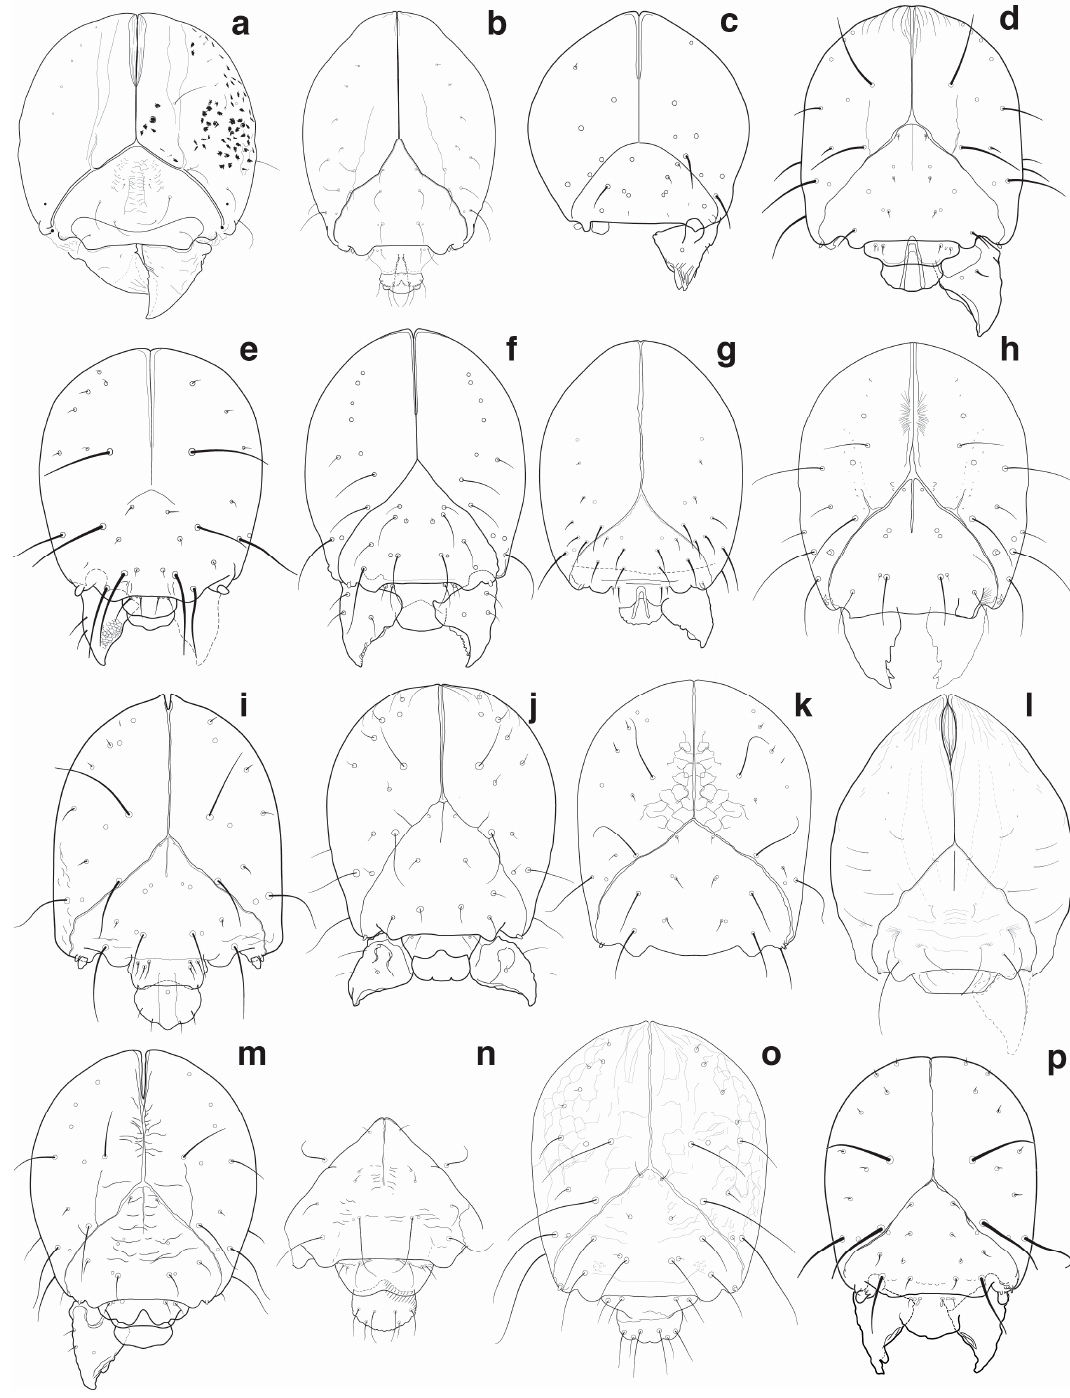
Figure 7. Head, larva, dorsal view: ( a ) Cyrtotrachelus ; ( b ) Eucalandra ; ( c ) Nephius (= Anius ); ( d ) Cosmopolites ; ( e ) Dryophthorus ; ( f ) Diocalandra ; ( g ) Myocalandra ; ( h ) Nassophasis ; ( i ) Polytus ; (j) Rhodobaenus ; ( k ) Rhynchophorus ; ( l ) Poteriophorus ; ( m ) Sphenophorus maidis ; ( n ) Sphenophorus pontederiae ; and ( o ) Trochorhophalus